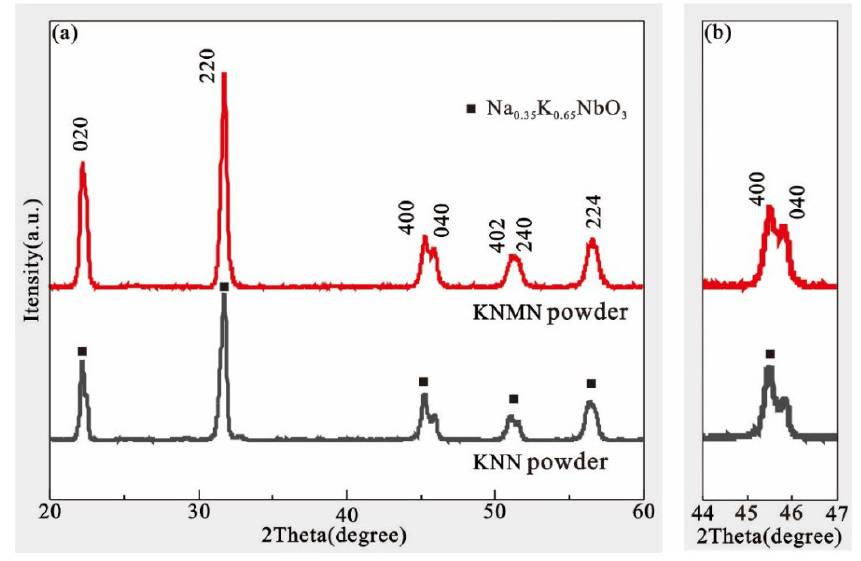
Figure 7. ( a ) XRD patterns of KNN and KNMN powders. ( b ) 44°–47° XRD extended patterns. Figure 8a represents the XRD patterns of the KNN and KNMN coatings. Both coat-